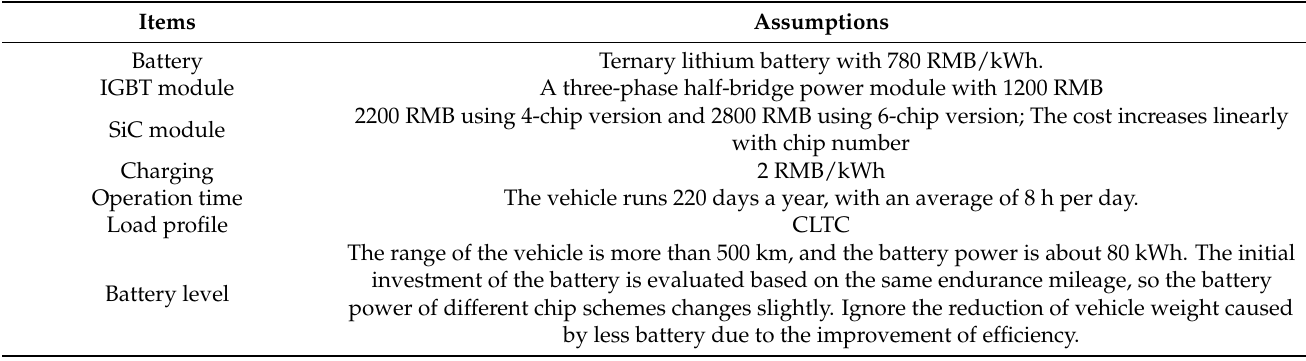
Table 7. Key Assumptions of Economic